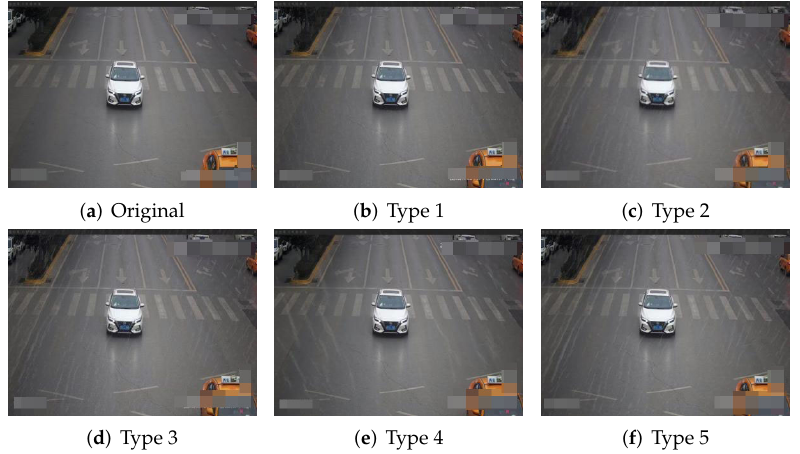
Figure 5. Rendered rain images with single vehicle. ( a ) Original clean image; ( b – f ) rendered rain images with 5 kinds of different rain-streak patterns.